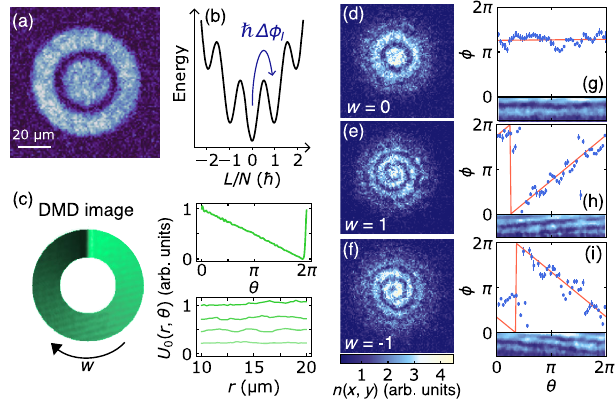
FIG. 2. Excitation and detection of the circulation state. (a) In situ image of the BEC superfluid in the trap configuration we employ to interferometrically probe the ring winding number. (b) Energy landscape of the ring superfluid as a function of the total angular momentum per pair L=N . The imprinting of an optical phase Δ ϕ operates the transition into one of the I metastable persistent current states at winding number w . (c) DMD-made light pattern, diagnosed by a secondary imaging camera, employed for the phase imprinting and corresponding light shift U 0 . In the top panel, U 0 ð θ Þ is averaged along the radial direction in the ring; in the bottom panel, U 0 ð r Þ is averaged over 0.07 rad across θ ¼ 0 ; π = 2 ; π ; 3 π = 2 for decreasing line intensity, respectively. The sharp opposite gradient at θ ≃ 2 π has a dimension of Δ θ ¼ 0 . 15 rad. (d) – (f) Interferograms of the BEC superfluid, obtained from a single absorption image after a TOF expansion of 1.2 ms without phase imprinting (d) and with ≃ 2 π in the clockwise (e) and a phase imprinting of Δ ϕ I anticlockwise (f) directions. (g) – (i) Fit of the local relative phase ϕ extracted from the interferograms. After changing the image into polar coordinates (bottom panel), a sinusoidal fit of each azimuthal slice of the interferogram is performed to extract ϕ as the relative phase shift (blue dots on top panels). The polar images comprise the radial region at 1 . 5 μ m < r < 12 μ m, cut into 100 azimuthal slices. Symbols (error bars) in the (g) – (i) top panels represent the weighted average (weighted standard deviation) over the fitted values of ϕ and their 1 σ uncertainty of the fit in bins of 0.125 rad size. A linear fit (red solid lines) provides a measurement of the winding number as the slope of the ϕ − θ curve. We obtain w ¼ 0 . 01 ð 2 Þ , w ¼ 1 . 00 ð 9 Þ , and w ¼ − 0 . 99 ð 9 Þ for panels (g) – (i),